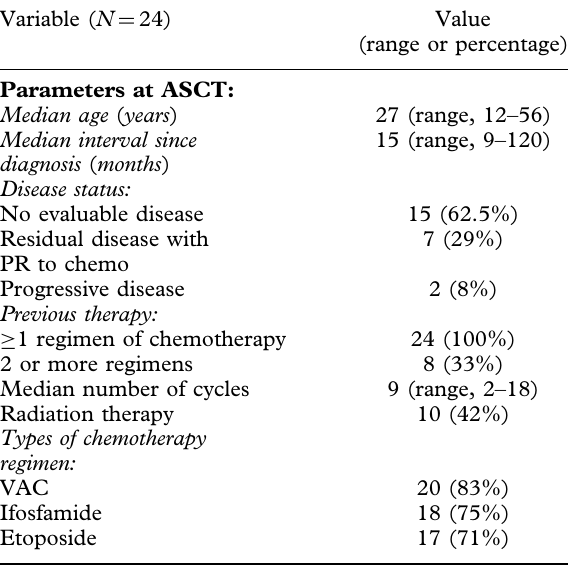
Table 2. The median interval between diagnosis and ASCT was 15 months (range, 9–120 months). At time of BMT, 15 of the 24 patients (62.5%) of patients had no evaluable disease. Most were at high Table 2. Patient characteristics at time of transplant Variable ( N ¼ 24) Value (range or percentage) Parameters at